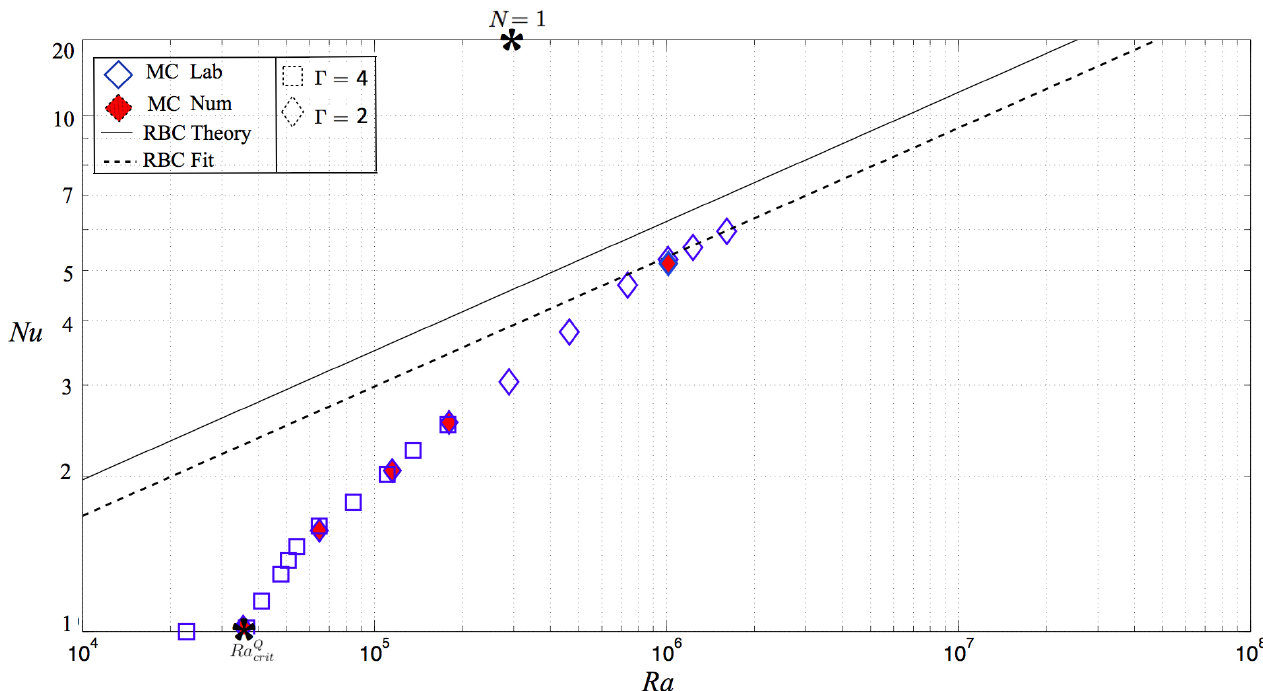
Figure 10. Magnetoconvection (MC) heat transfer measurements in liquid gallium. Heat transfer efficiency, parameterized by the Nusselt number, Nu , is plotted versus the buoyancy forcing, parameterized by the Rayleigh number, Ra . The Chandrasekhar number has a fixed value of Q = 3 . 5 × 10 3 in this suite of experiments; the critical Rayliegh number = π 2 Q = 3 . 45 × 10 4 . The low Rm Ra Q interaction parameter, N , reaches unity at c crit roughly Ra = 3 × 10 5 . For lower Ra values, Lorentz forces are expected to dominate inertia; for higher Ra , inertia should overcome Lorentz